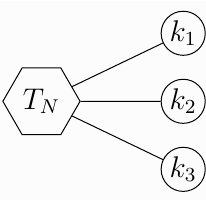
. The supersymmetry enhances 3